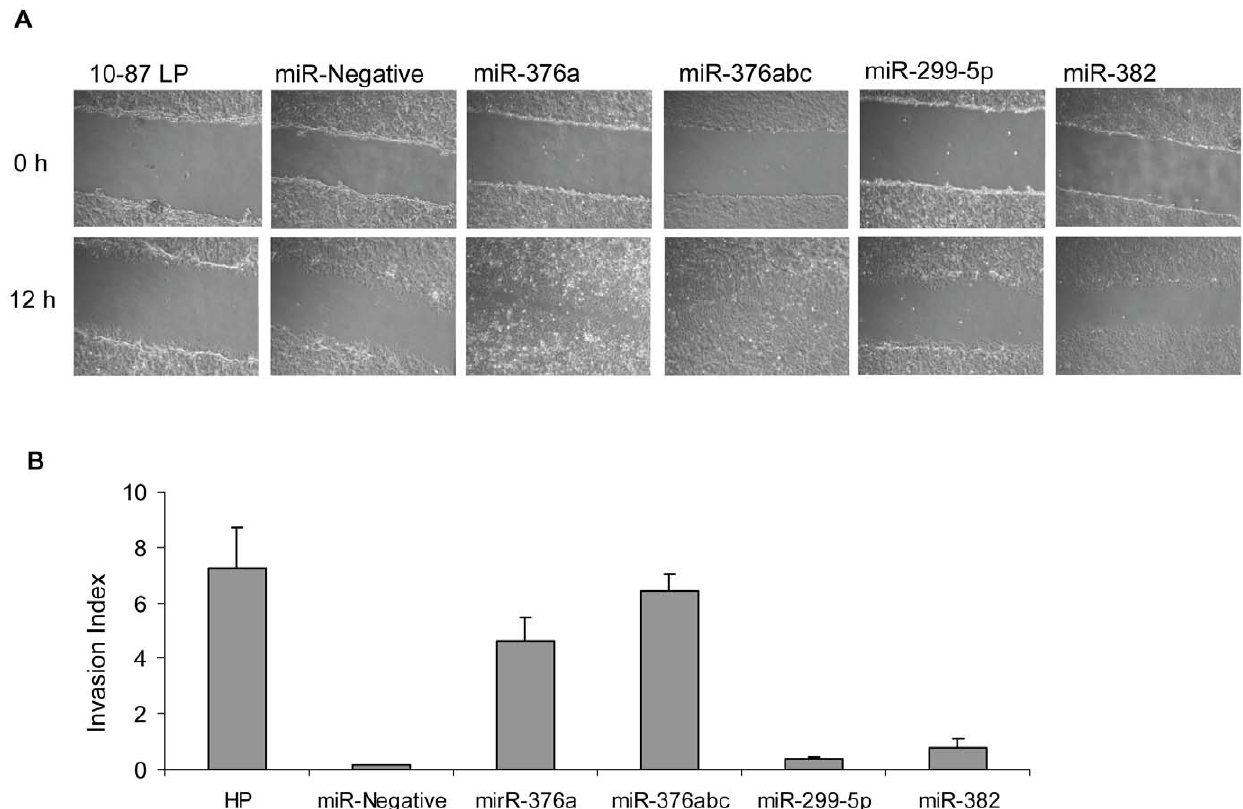
Figure 4. Correlations of over-expression of miRNA with migration and invasive phenotypes. (A) Wound-healing assay of stably expressing miR-376a, miR376abc (a polycistronic cluster of miR-376a, miR-376b and miR-376c), miR-299-5p or miR-negative and 10-87 LP cells;